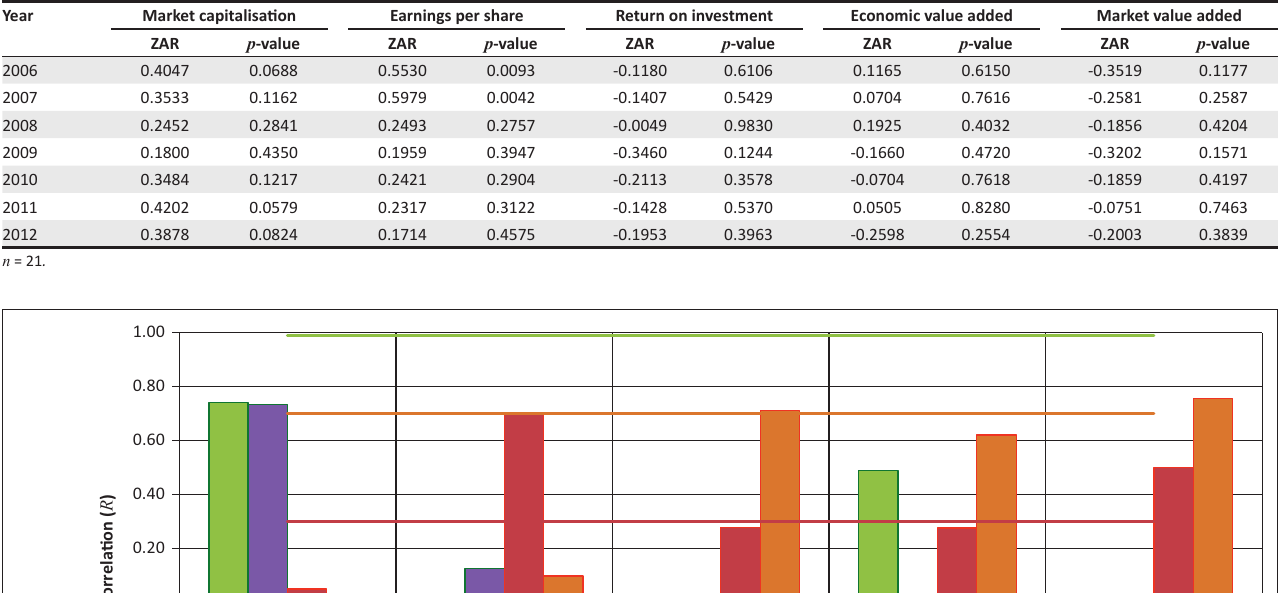
TABLE 7: Correlation analysis: Fixed pay and short-term incentives.